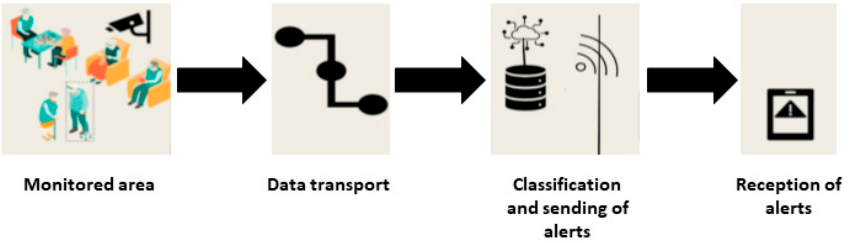
Figure 1. Components for a fall detection model.